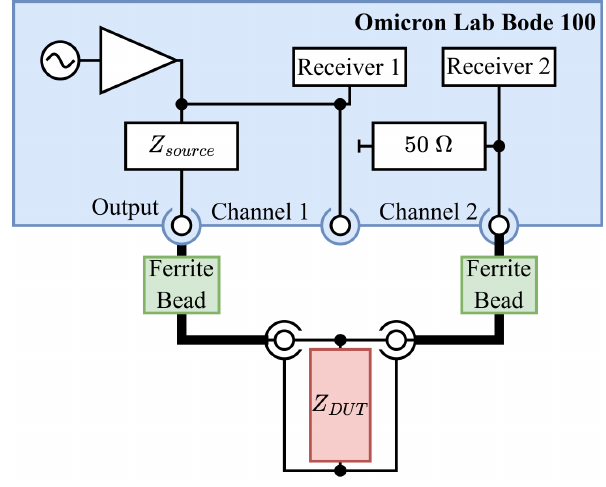
Figure 19. Shunt-thru measurement method